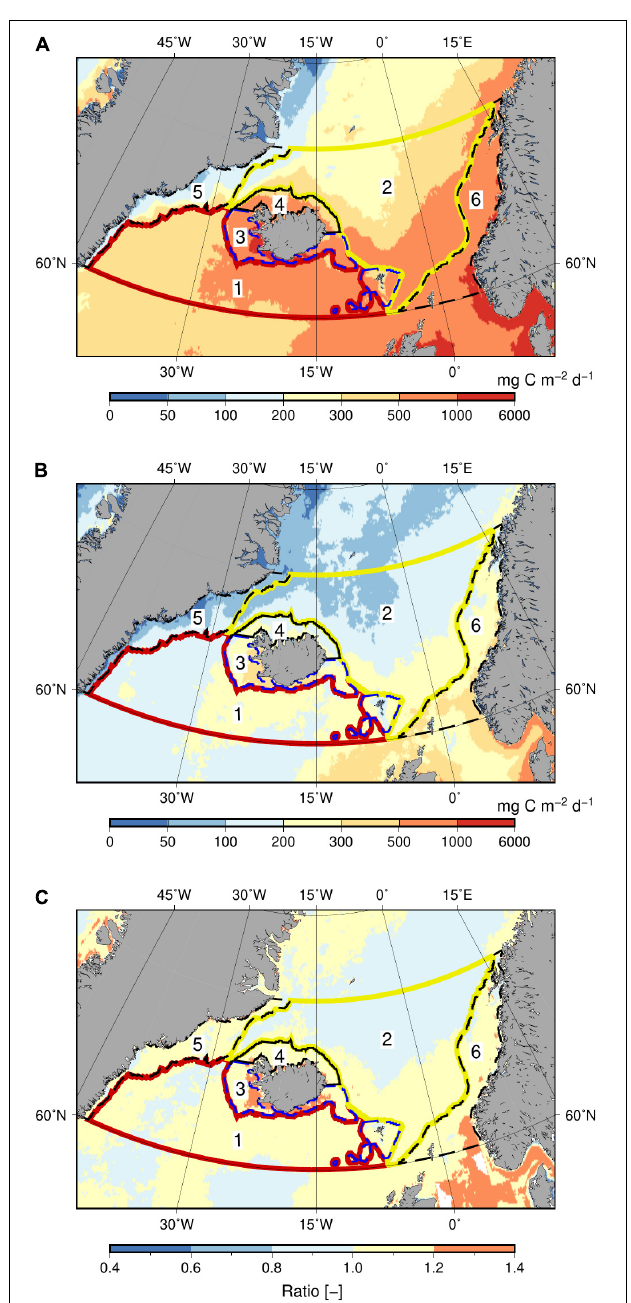
FIGURE 2 | (A) Annually averaged PP in the period 2003–2013 calculated by the VPP-model and (B) the associated standard deviation. (C) The ratio of PP calculated by the VPP- and the VGPM-model, i.e., VPP/VGPM. The six subdomains are shown.